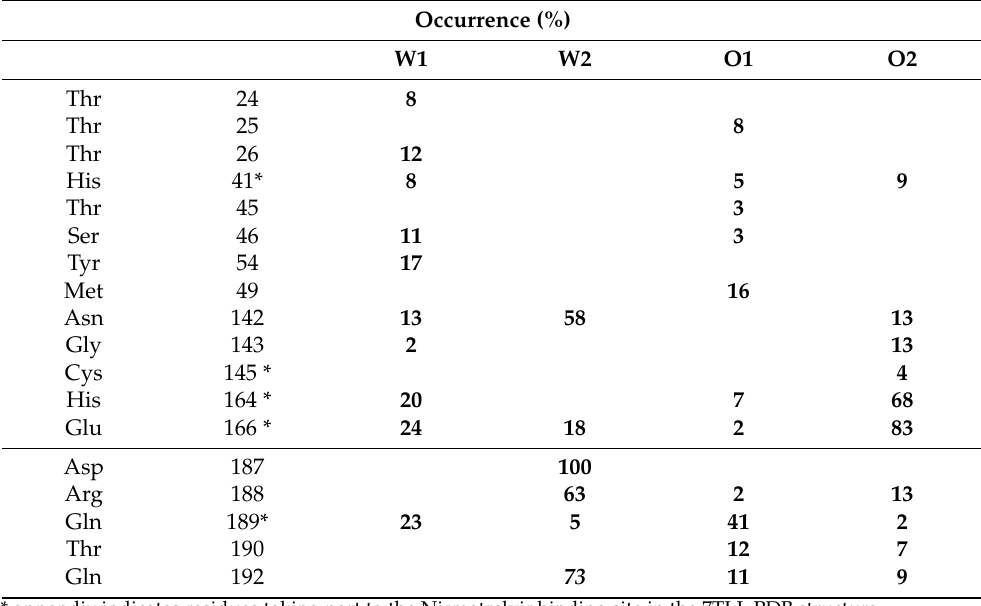
Table 1. Percentage of occurrence of ligand-protein residue connections along the trajectory frames. For each pair, the sum of the hydrogen bonds between any residue atoms is considered.